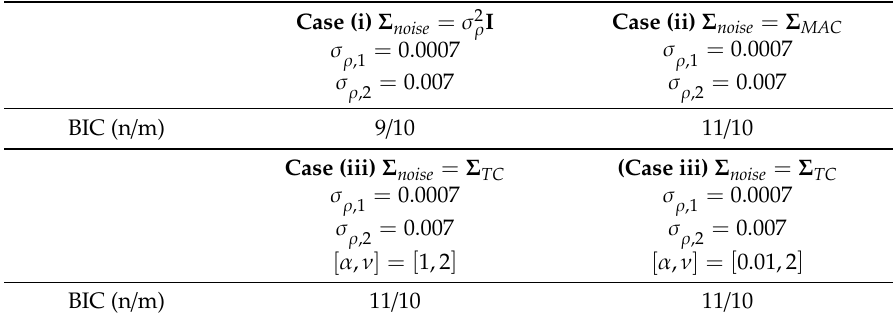
Table 2. The optimal number of control point (CP) in both directions (n / m) is determined with Bayesian information criterion (BIC) for case (i), (ii) and (iii) corresponding to di ff erent noise structures. Unit of STD is [m]. Case (i): simple case, heteroscedasticity. Case (ii): complexity degree 1: heteroscedasticity +